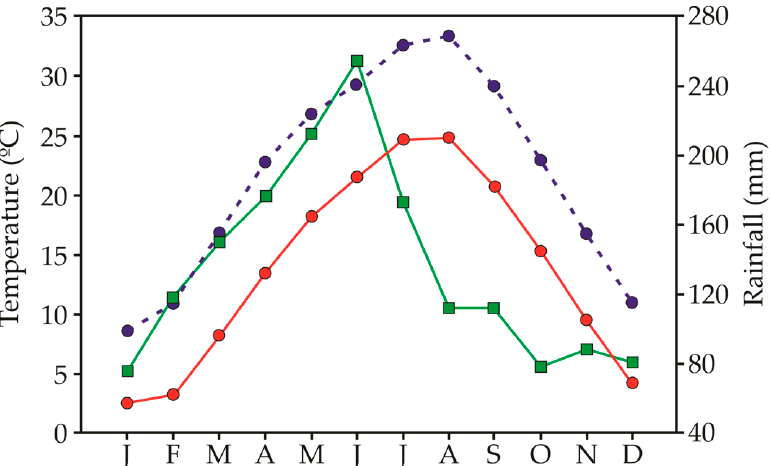
Figure 4. Minimum temperature (red circles), maximum temperature (blue circles) and precipitation (green squares) registered as the mean of the 5 years after the start of the experiment (2015–2019) in Guling, Jiangxi, China.